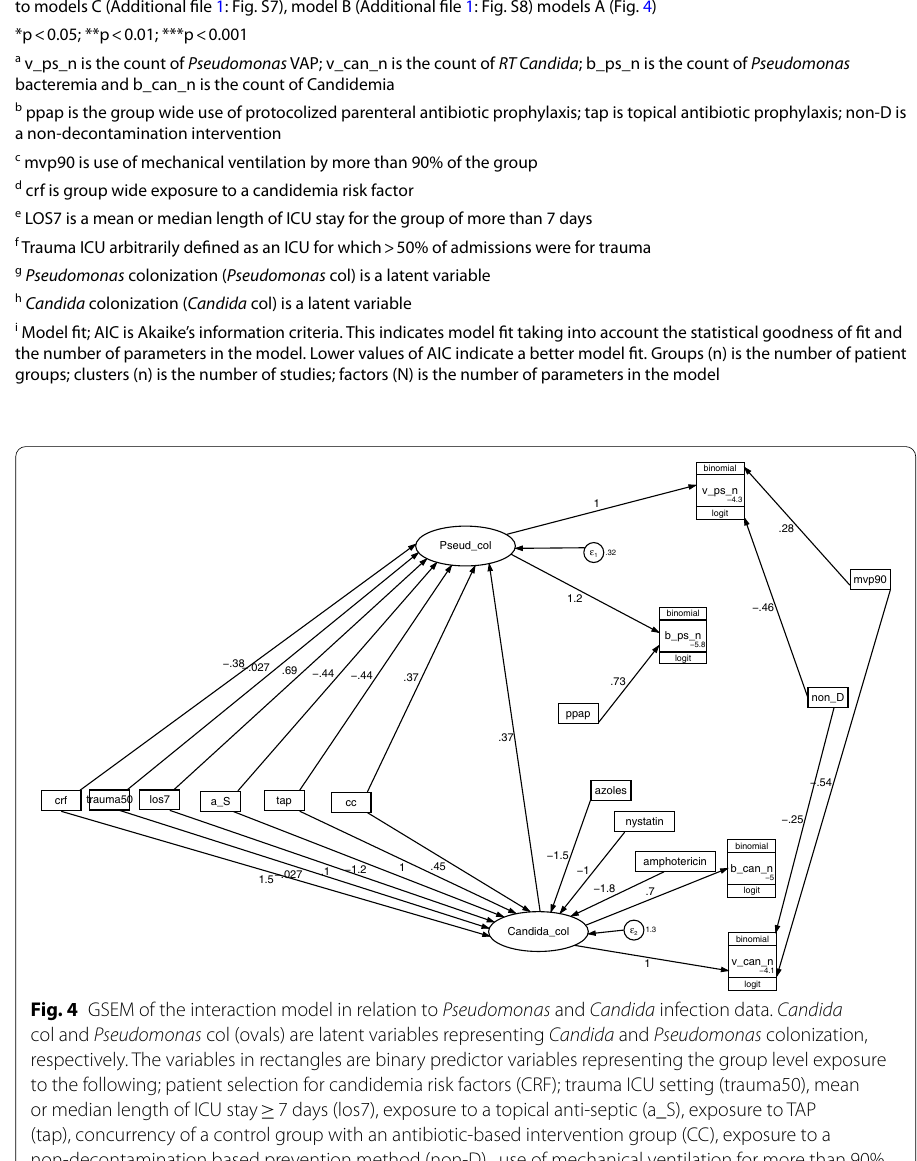
versus benchmark.